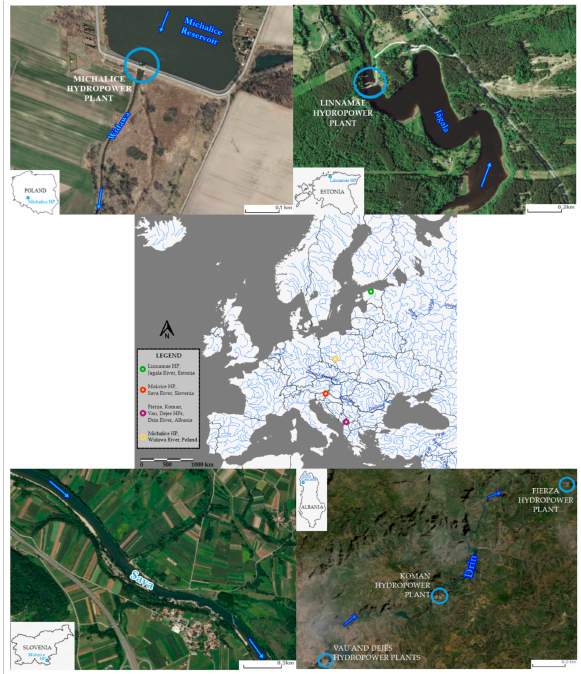
Figure 3. Location of analyzed case studies: hydropower plants in Estonia, Poland, Slovenia, and Albania (map base: https: // www.arcgis.com / home / webmap / viewer.html; accessed on 10 July 2020). QGIS 2.8.4 (QGIS Development Team) and Excel 2013 (Microsoft, Washington, DC, United States) were used to create graphic materials.